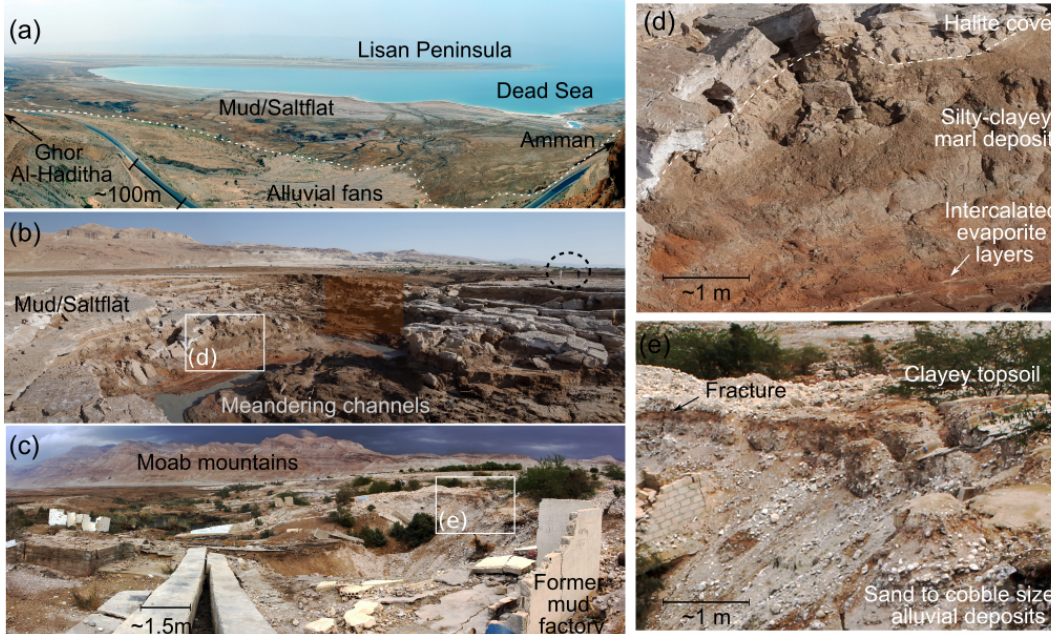
Figure 2. Field photos of the Ghor Al-Haditha study area. (a) View from the Moab mountains near Wadi Abu-Darat onto the former Dead Sea lake bed. The dashed white line marks the boundary between alluvium and lacustrine deposits, and it is approximately equivalent to the shoreline position in 1960. (b) Vice versa view from the DS lake bed towards the Moab mountains, with a section of a meandering stream channel and associated deformed ground. (c) Area around canyon CM5 with the destroyed Numeira mud factory. (d) Zoom-in of lacustrine deposits. (e) Zoom-in of alluvial fan